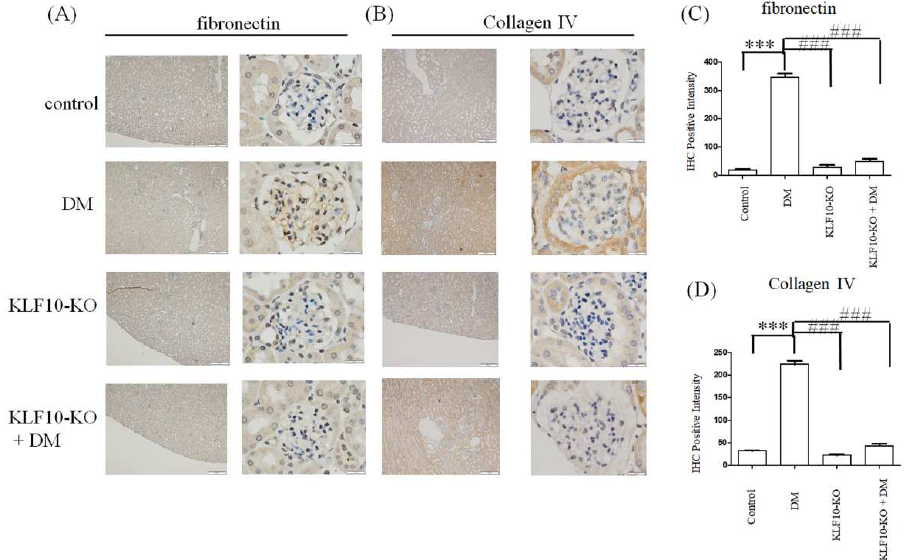
Figure 2. Knockout of KLF10 repressed fibronectin and type IV collagen expression in diabetic (DM) mice. Kidney glomerular mesangium sections derived from control or KLF10-KO mice with or without diabetes (DM) were subjected to immunostaining with fibronectin ( A ) and type IV collagen ( B ) primary antibody. Left panel: magnification of 100 × , right panel: magnification of 1000 × . ( C ) Fibronectin and ( D ) collagen IV; data are presented as means ± standard deviation from three different mice ***: p < 0.001 compared with the control group. ###: p < 0.001 compared with the DM group. Scale bar: 200 µ M at 100 × and 20 µ M at 1000 × .